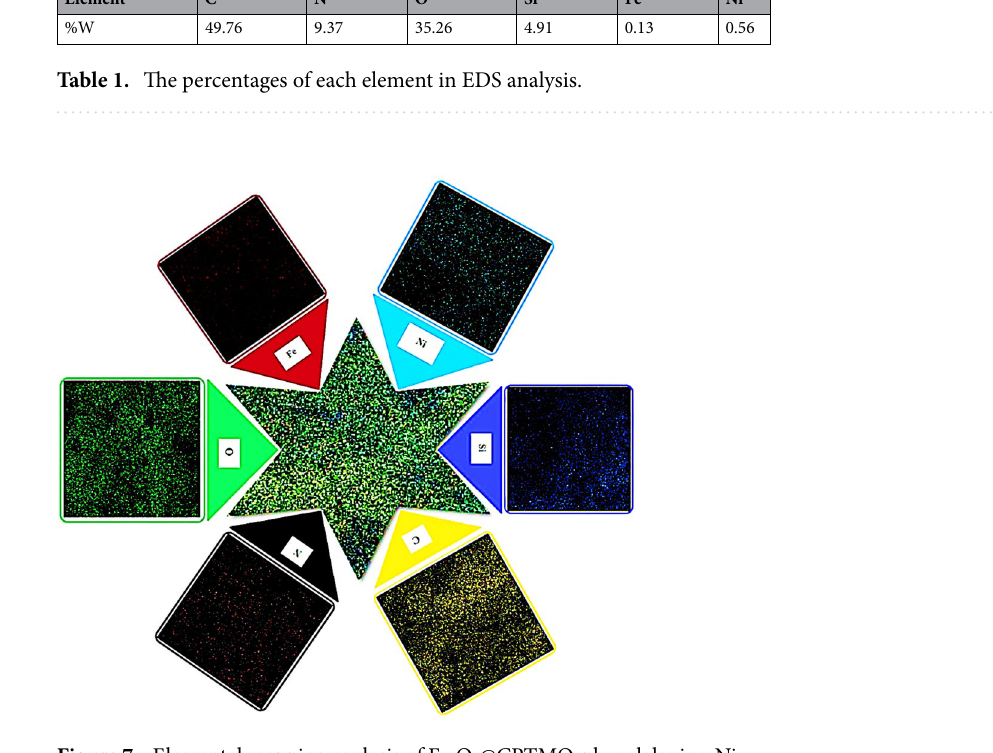
Figure 7. Elemental mapping analysis of Fe 3 O 4